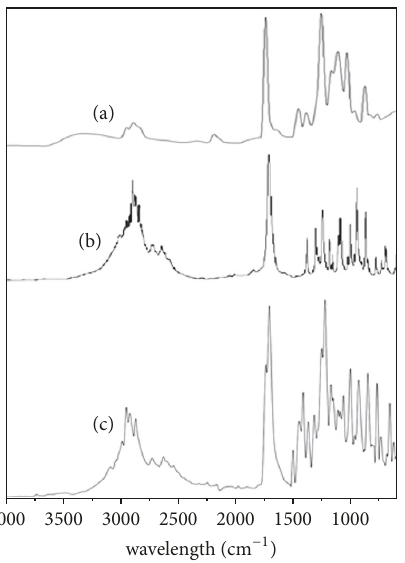
Figure 1: IR spectra of (a) PECA, (b) ibuprofen, and (c) PECA loaded with IB.